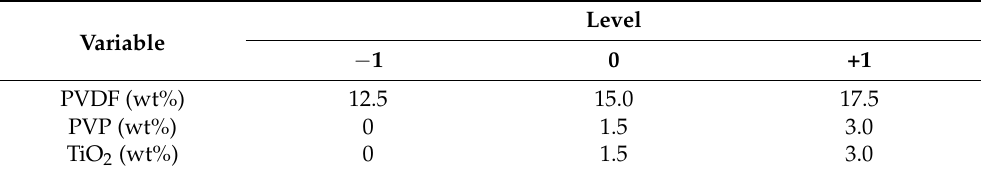
Table 2. Independent variable values for the central composite design of TiO 2 -modified membranes.